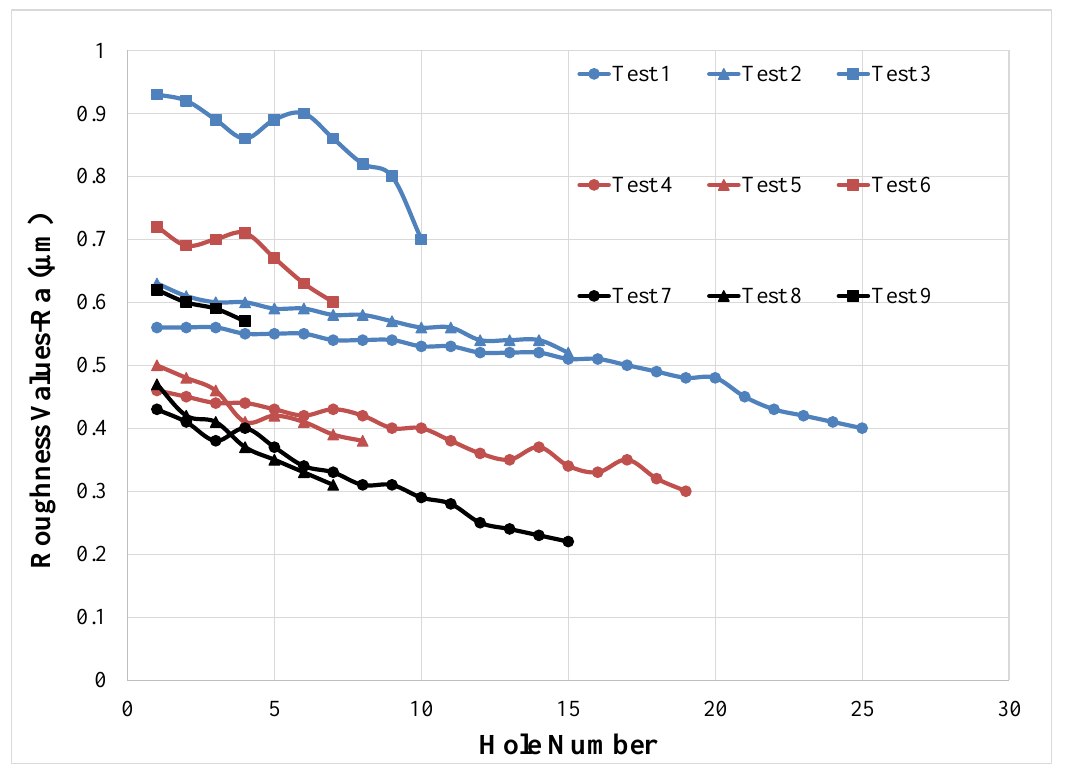
Figure 18. Roughness values vs. the number of drilled holes.